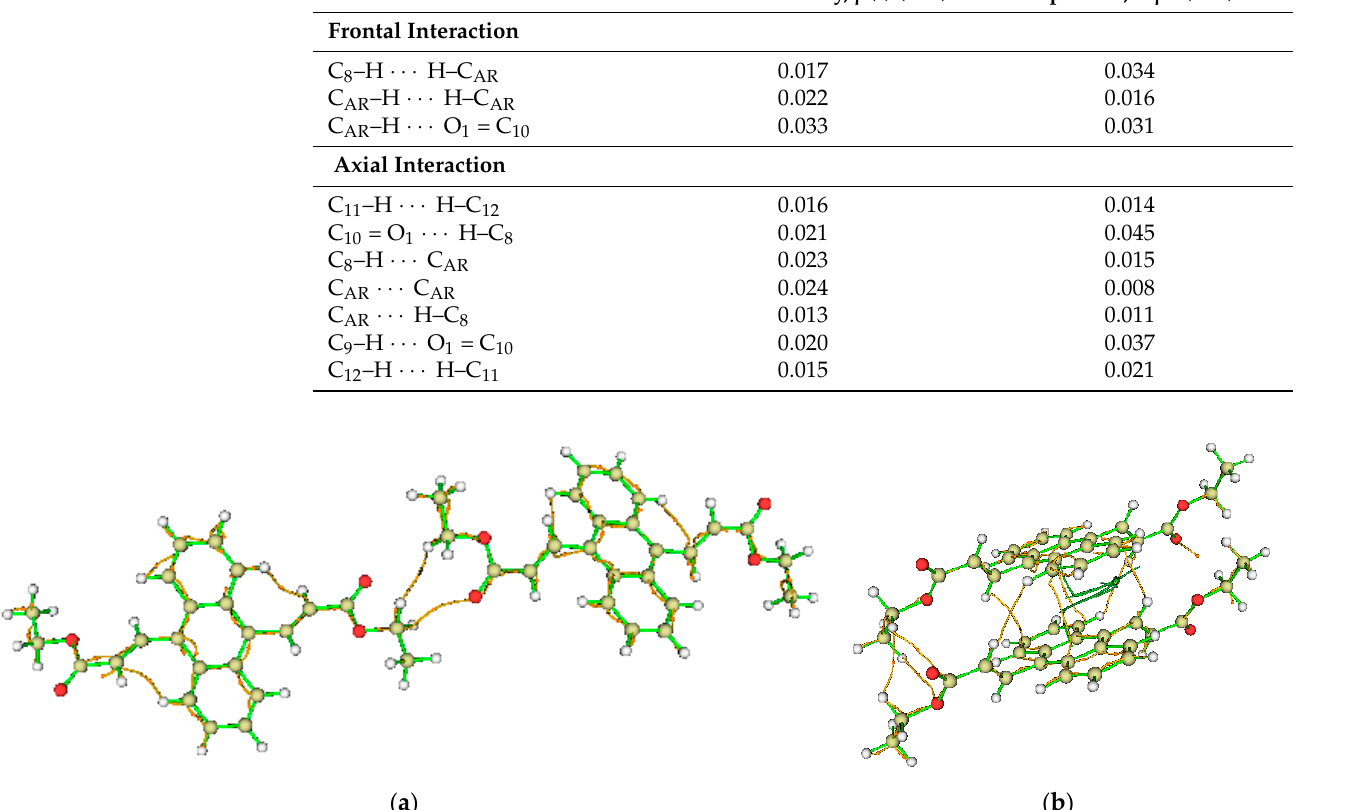
Figure 14. Molecular graph of the frontal ( a ) and axial ( b ) interactions between DADB molecules in the crystals, where the orange lines correspond to the bond path, and the small orange circles to the bond critical point.